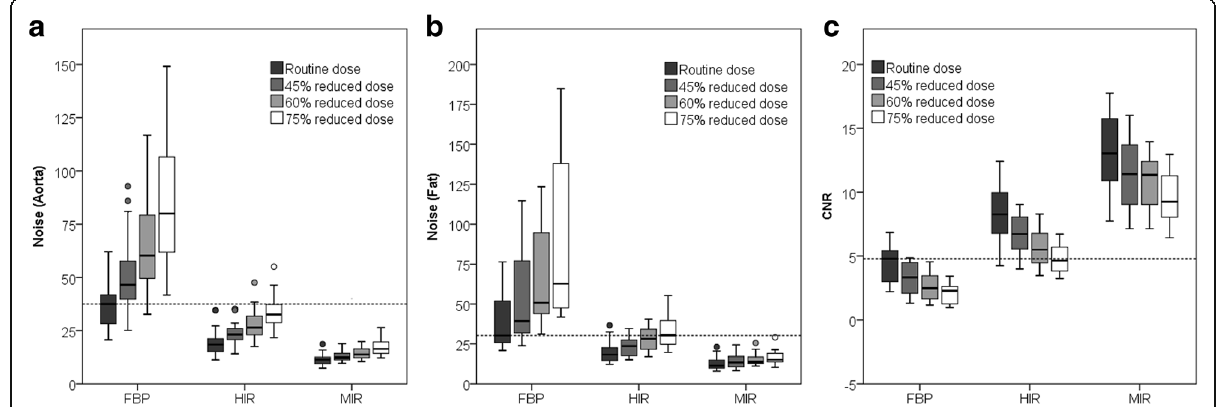
Fig. 5 Noise ( a and b ) and CNR ( c ) measured at different dose levels with FBP, HIR and MIR. Noise was measured in the aorta ( a ) and subcutaneous fat ( b ). The dotted line represents the reference (FBP at routine dose). CNR contrast-to-noise ratio, FBP filtered back projection, HIR hybrid iterative